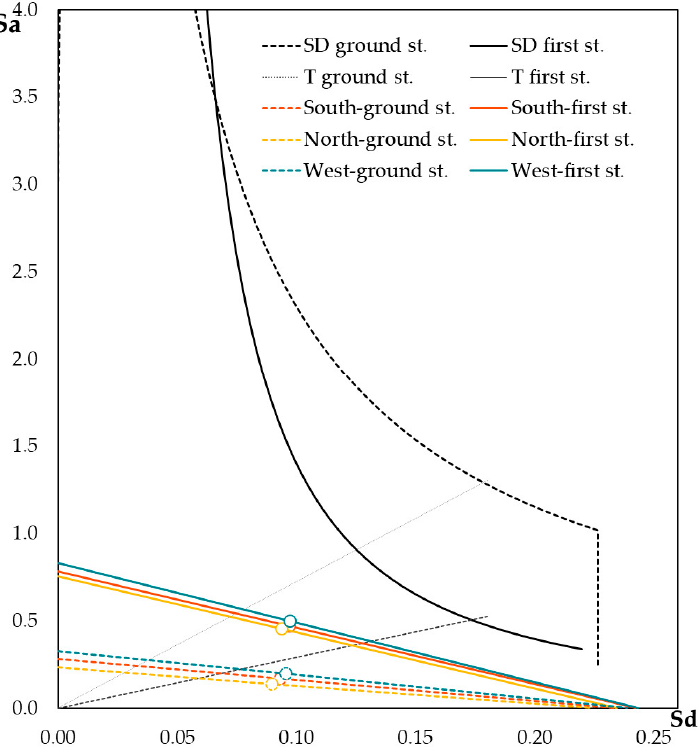
Figure 13. Capacity curves of local mechanisms and demand spectra at ground and first floors (empty dots represent displacement capacity at SD limit state; radial lines indicate structure’s period T at displacement capacity). Table 4. Performance ratios ζ E at DL and SD limit states for single-unit model in as-built conditions according to kinematic analyses.